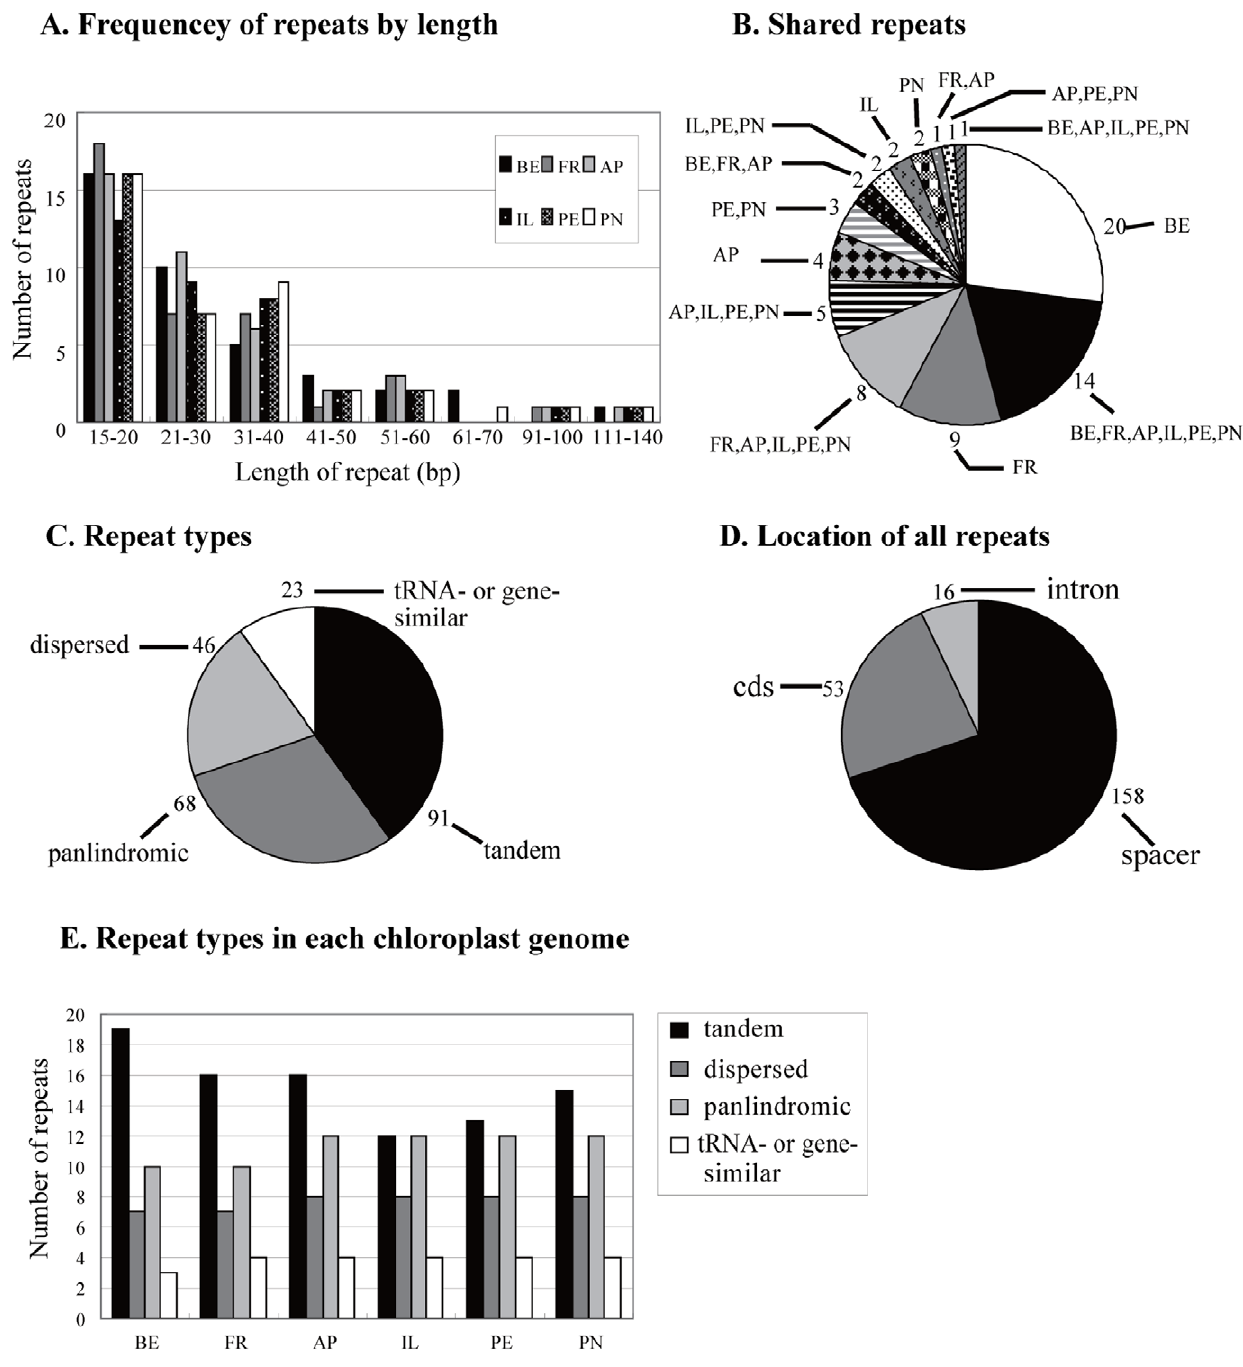
Figure 3. Repeat analyses. BE, B. emeiensis ; FR, F. rimosivaginus ; AP, A. purpurea ; IL, I. longiauritus ; PE, P. edulis ; PN, P. nigra var. henonis . (A) Histogram showing the number of repeats in the six woody bamboo chloroplast genomes. (B) Summary of shared repeats among six bamboos. tRNA- or gene-similar repeats are excluded. (C) Composition of the 228 repeats from six bamboos. (D) Location of the 228 repeats from six bamboos. Repeats that occurred in two regions were counted in both. (E) Histogram showing the number of four repeat types in each bamboo chloroplast genome.